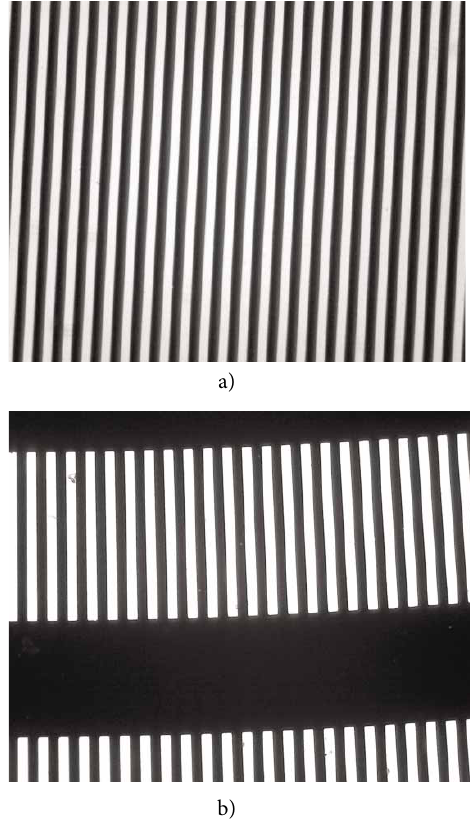
Fig. 6. Rastre scales made by litographic means: